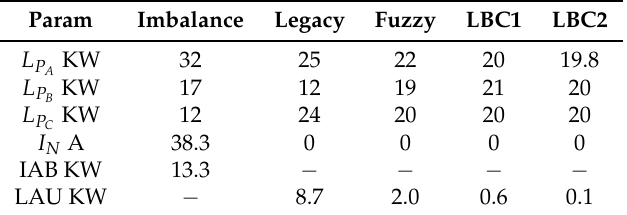
Table 9. Load-Balance Performance.